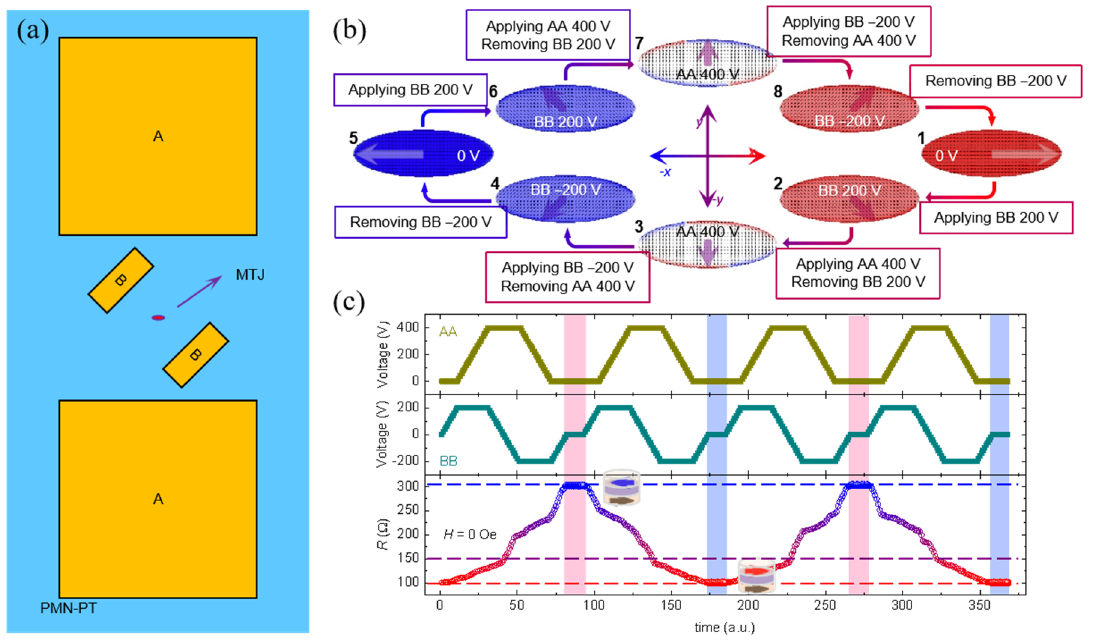
Figure 11. Strain-driven fully switching of TMR by voltage. ( a ) Sketch of the two electrode pairs design in the sample architecture. An MTJ stack was placed at the central area of two electrode pairs. ( b ) Local strain-driven 180 ◦ magnetization rotation was achieved via sequential unidirectional 45 ◦ rotations by voltage. ( c ) Fully switching process of the MTJ is achieved by exerting successive voltages to the two electrode pairs. Reproduced with permission from reference [113].